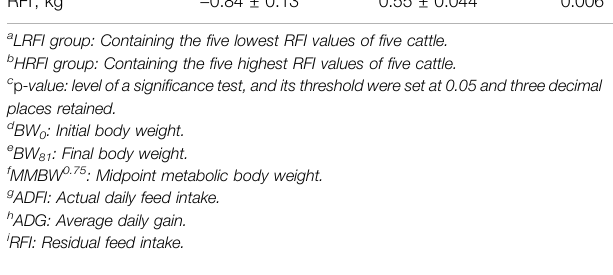
Traits LRFI group